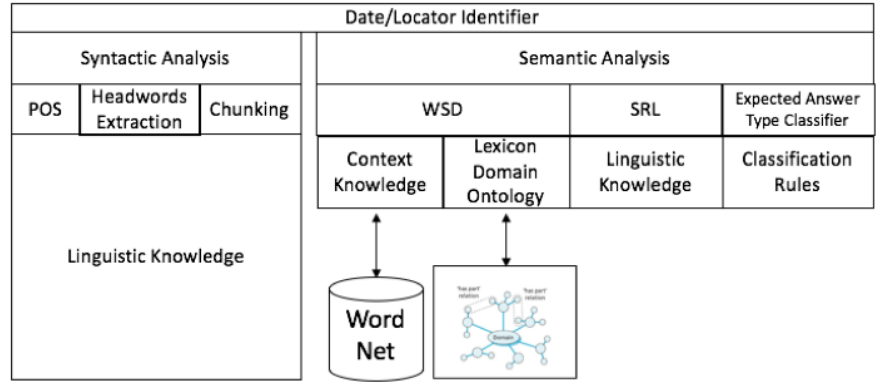
Figure 4. The proposed KSD approach.